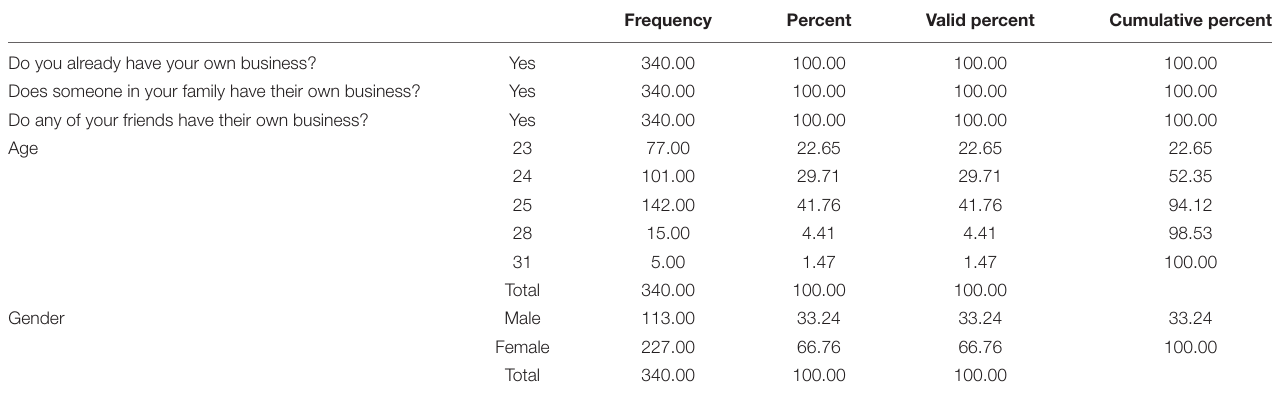
TABLE 1 | The descriptive statistics of